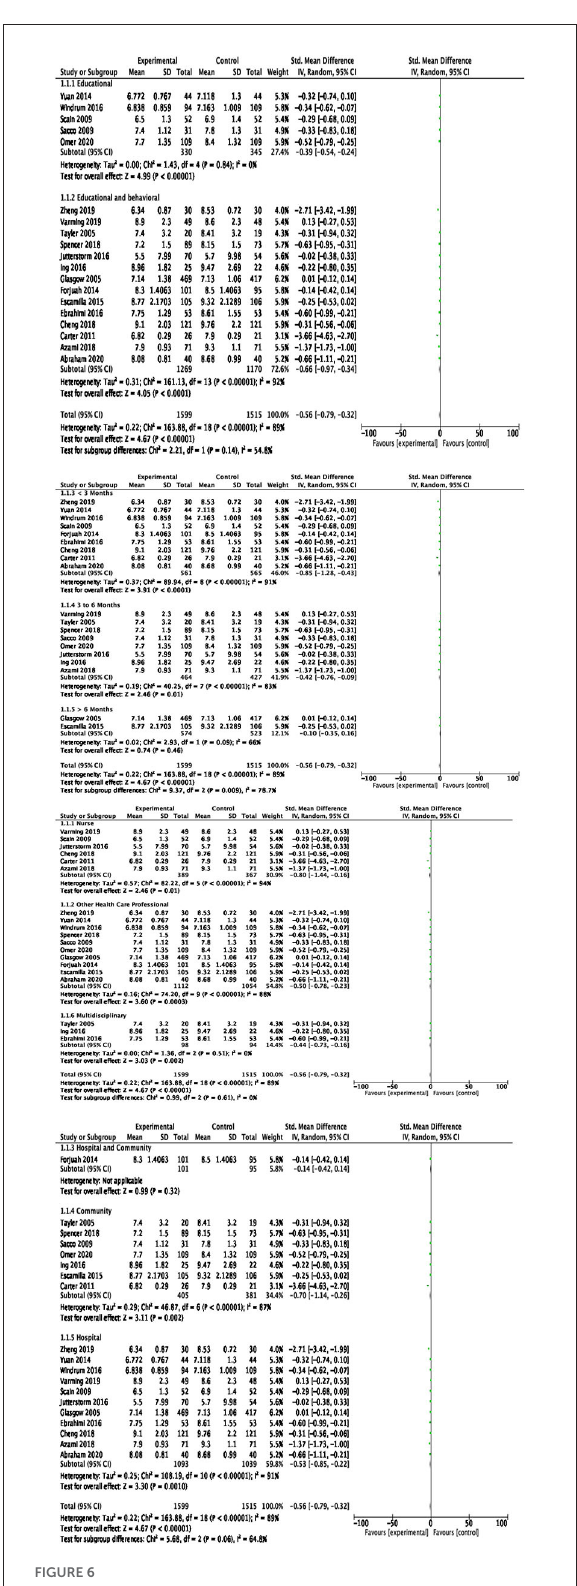
FIGURE6 (A) Pooled effect size of HbA1c in studies sub-grouped by components of intervention; (B) pooled effect size of HbA1c